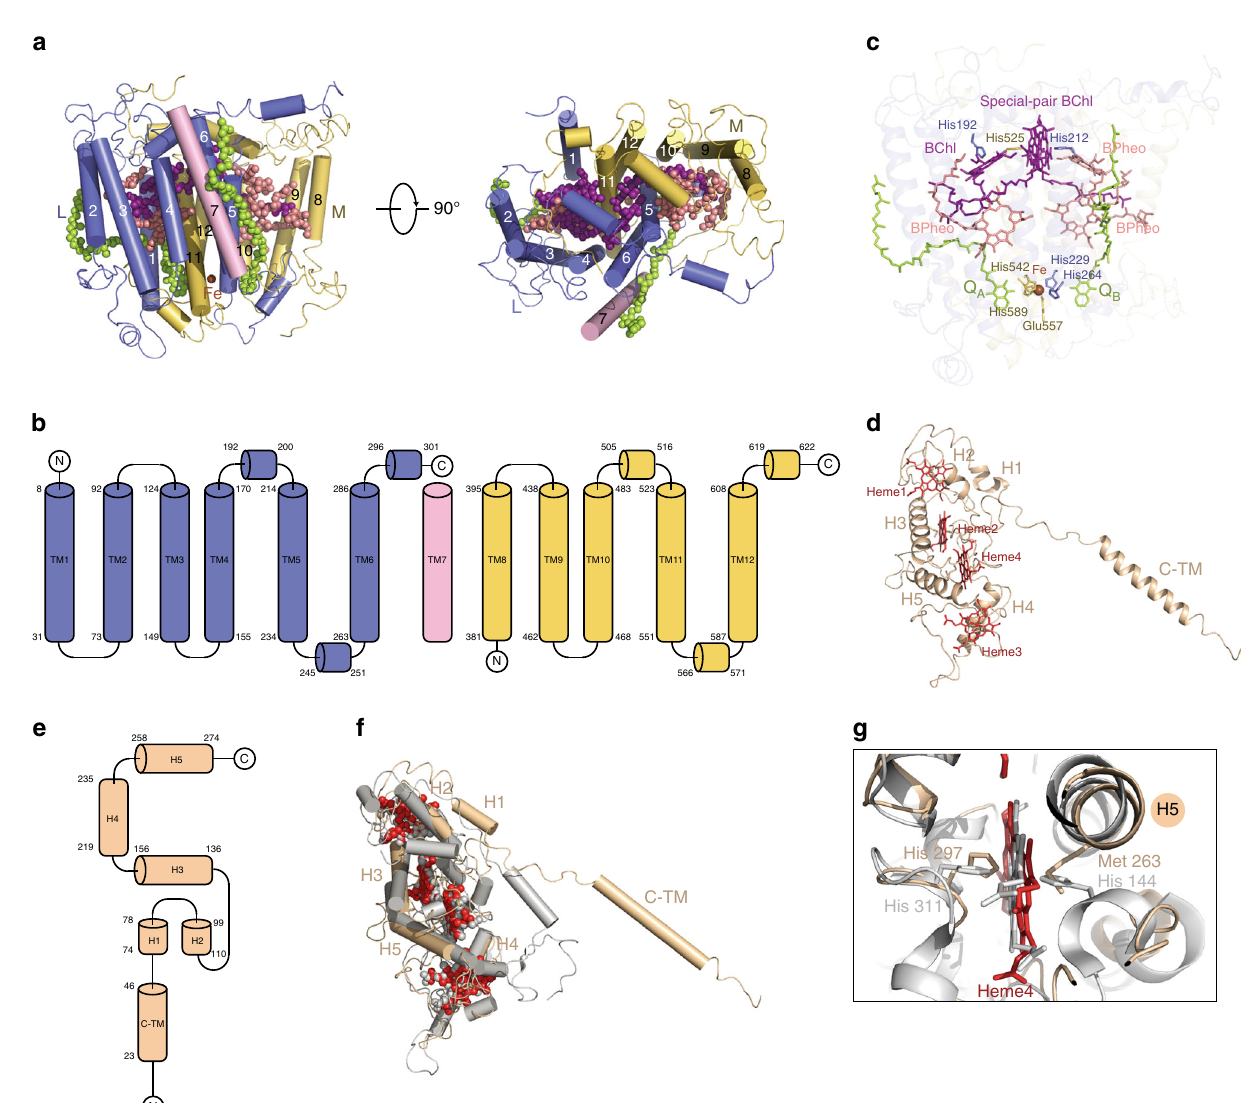
Fig. 2 Architecture of the reaction center. a The cartoon presentation of the L and M subunits in side view (left) and top view (right), and the cofactors are shown as spheres. b The topology diagram of L and M subunits. The TM7 (light pink) is an independent transmembrane helix in the current complex. c The cofactors in L and M subunits. To highlight the cofactors, the apoprotein of L- and M subunits are shown as 70% transparency. The amino acids coordinate the BChl, and iron ion are shown in sticks and labeled. d , e The cartoon ( d ) and topology ( e ) diagram of the Cyt c subunit, the hemes are shown as red sticks. f Structural comparison of the Cyt c subunit from T. tepidum (gray) and R. castenholzii (wheat). g The residues that coordinate heme 4 are different between T. tepidum (gray, accession code 3WMM) and R. castenholzii (wheat). The color codes for R. castenholzii are the same as Fig.